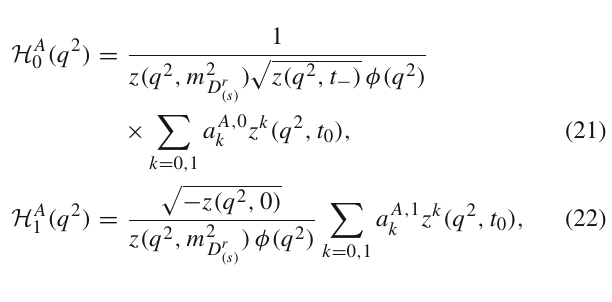
helicity form factors on M 2 and s 0 = 7 GeV 2 . The values 1